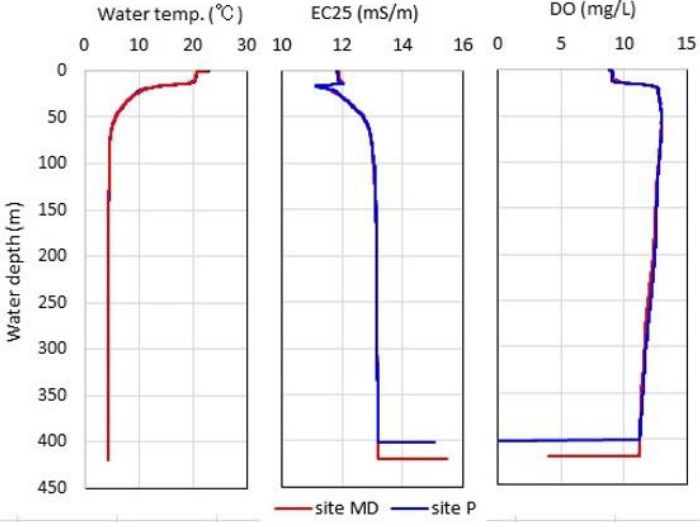
Figure 6. Vertical profiles of water temperature, EC25 and DO at sites MD and P on 10 September 2020 (Figure 1).